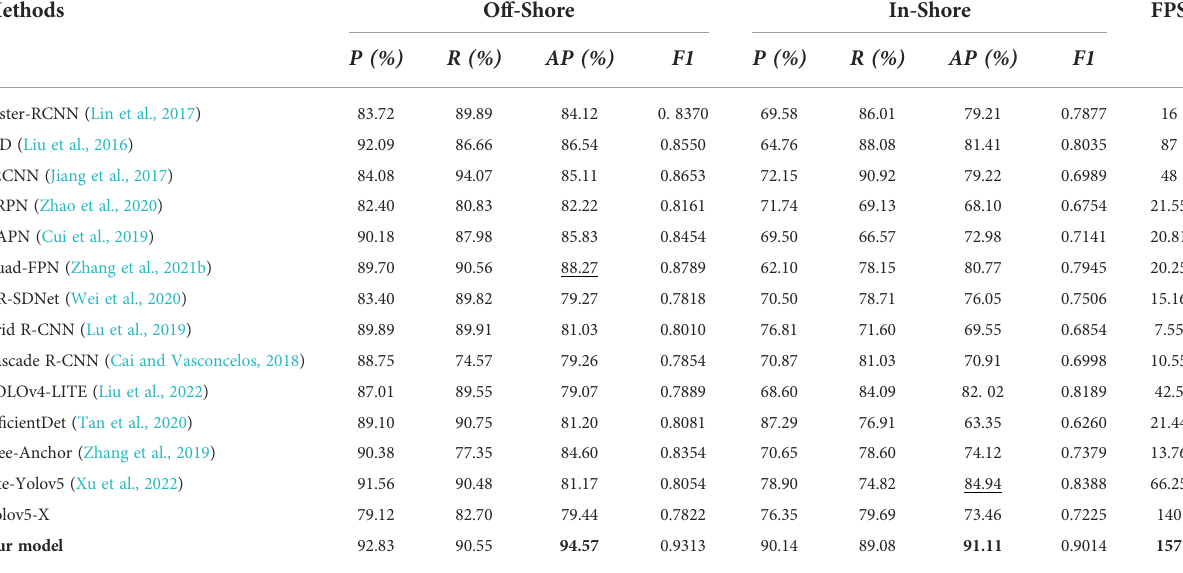
TABLE 4 The identi fi cation outcomes of various state-of-the-art CNN based approaches on offshore and inshore ship scene for AirSARship Dataset. Methods